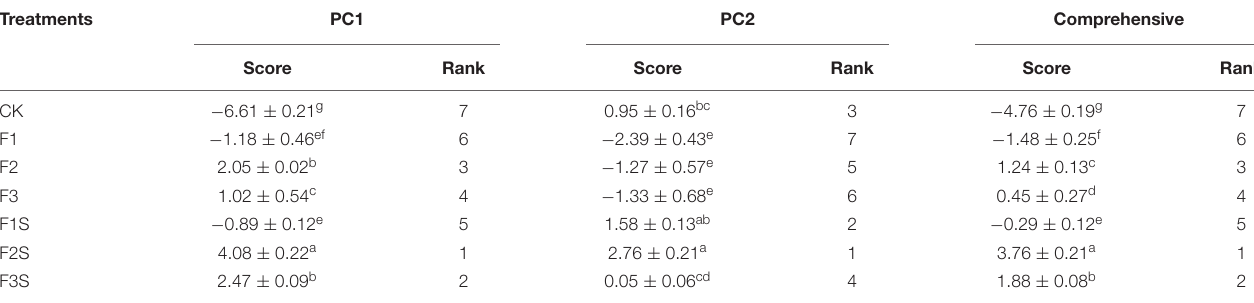
TABLE 6 | Scores and ranks of principal components and comprehensive scores for fertilizer treatments. Treatments PC1 PC2